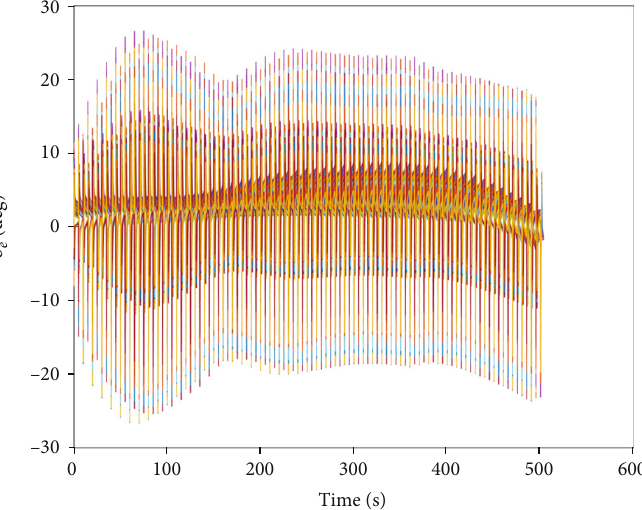
Figure 32: Elevators in the Monte Carlo simulations.